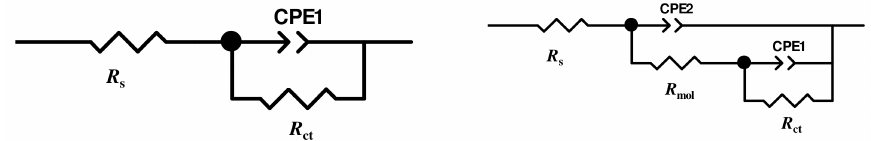
Figure 4. Equivalent electrical